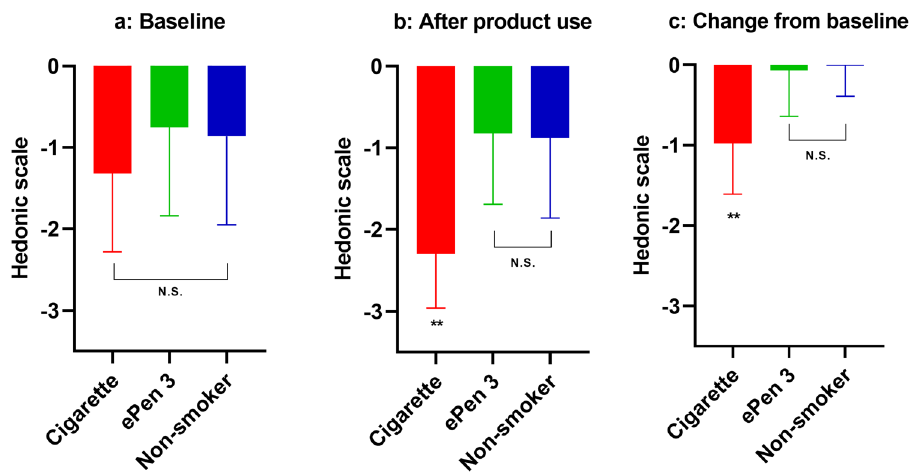
Figure 3. Differences in hedonic scoring before and after product use. Values are mean and SD of CSs, ECs and NSs (n = 11 each group) at baseline ( a ), after product use (cigarette and e-cigarette groups only) ( b ) and differences from baseline ( c ). ** p ≤